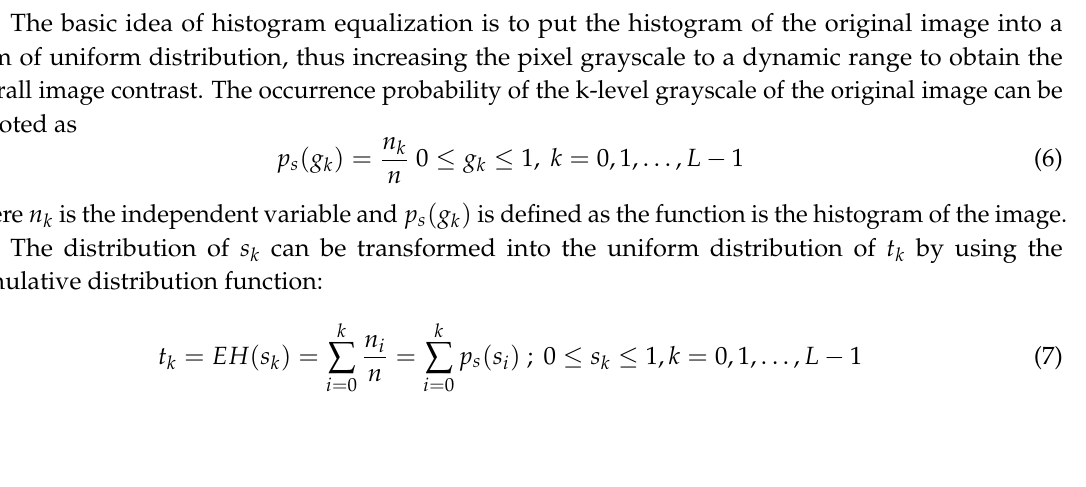
Figure 2. Graphical illustration of the proposed method.